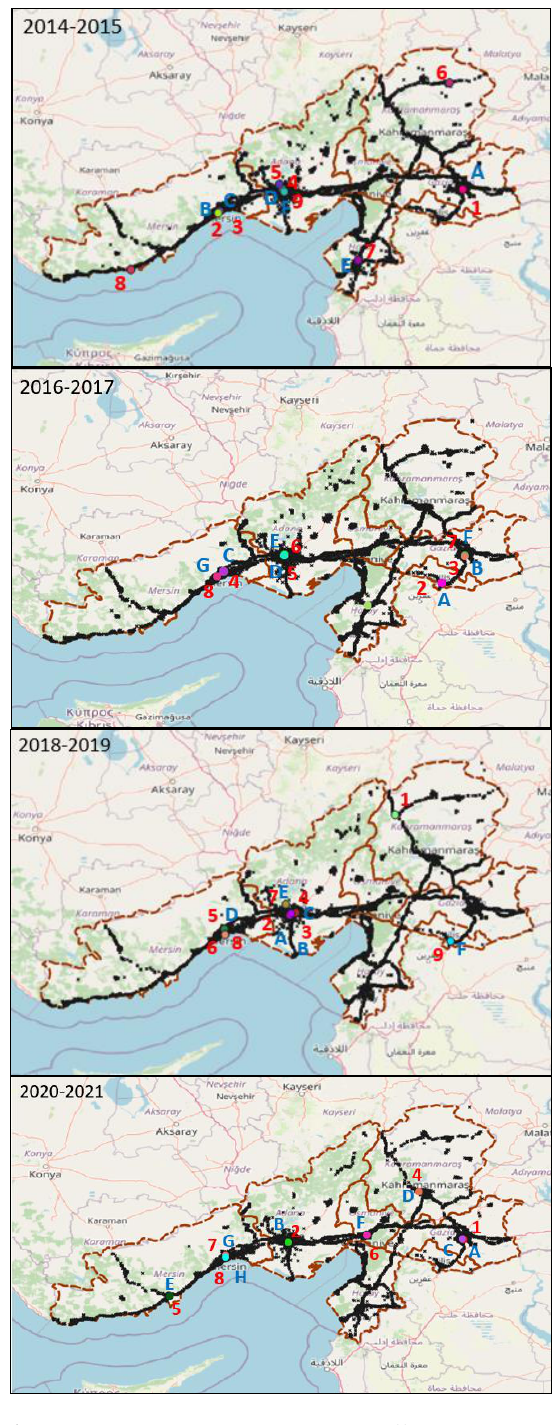
Figure 3. Mersin Region Speed-related Traffic Accident